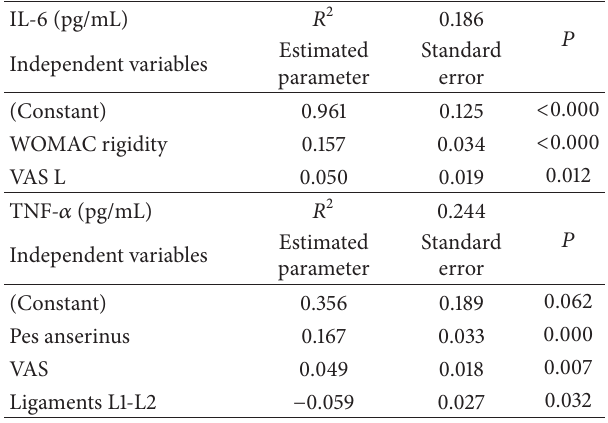
Table 5: Stepwise multiple linear regression models for IL-6 and TNF- 𝛼 and age, VAS, WOMAC pain subscale, WOMAC rigidity subscale, WOMAC physical activity subscale, and pressure pain threshold values (in kg/cm 2 ) in 24 studies